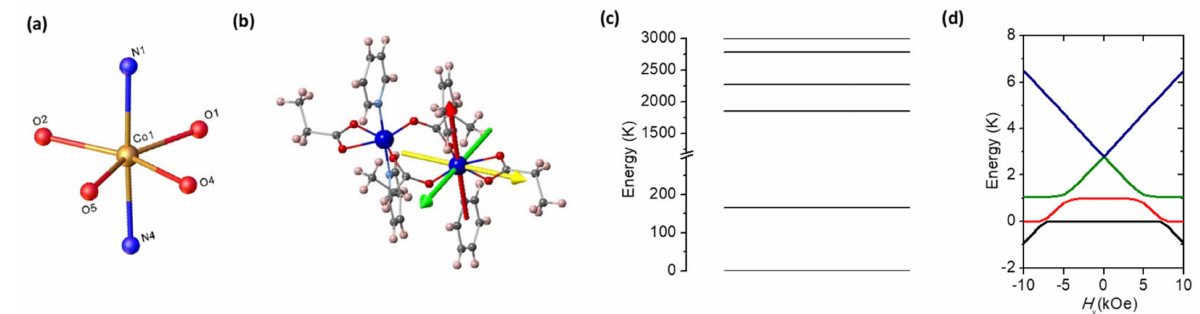
Figure 2. Single-ion properties. ( a ) Coordination sphere around Co(II) ion; ( b ) ab initio calculated easy axes of magnetization (the hard axis (HA, in red) is along the N-Co(II)-N axis; the easy axis (EA, in green) and intermediate axis (IA, in yellow) lie in the equatorial plane); ( c ) ab initio calculated energy levels of the six Kramer’s doublets; ( d ) energy level diagram for Co(II)-Co(II) S* = 1/2 dimer, with J * x /k B = − 0.5 K, J * y /k B = − 2.3 K and J * z /k B = − 0.5 K, as a function of magnetic field applied along easy